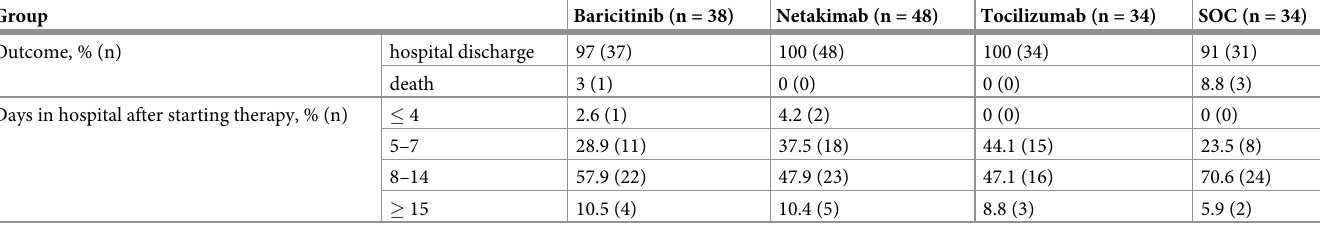
Data presented as % (n), where n = number of patients; % = percentage. Evenness of parameters distribution between groups was examined with Kruskal-Wallis and Dunn